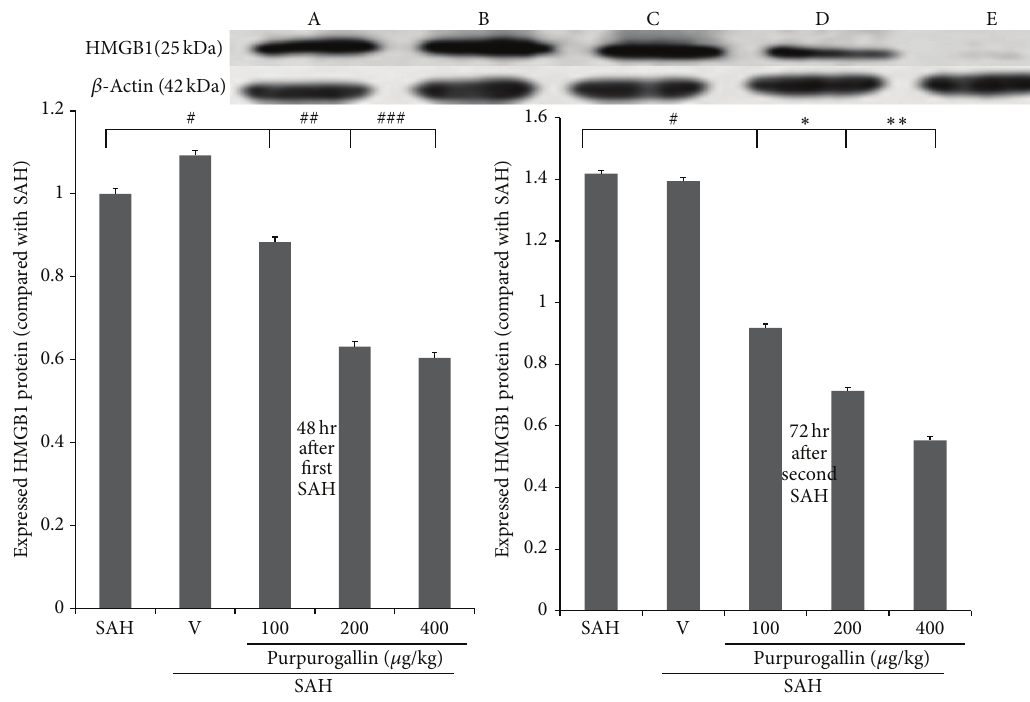
Figure 3: High-mobility group protein B1 (HMGB1) expression on 24 hr after first SAH and 72 hr after second SAH, respectively (Western blot). (A) SAH; (B) SAH + vehicle; (C) 100ug/kg/day purpurogallin + SAH; (D) 200 ug/kg/day purpurogallin + SAH; and (E) 400 ug/kg/day purpurogallin in SAH rats. Purpurogallin tended to decrease HMGB1 expression in 48hr after the induction of SAH. By the end of second SAH, purpurogallin dose-dependently attenuated HMGB1 protein expression. ∗,∗∗ 𝑃 < 0.01 , experimental animals compared with the SAH group. # , ## , ### 𝑃 > 0.05 , compared with the animals subject to